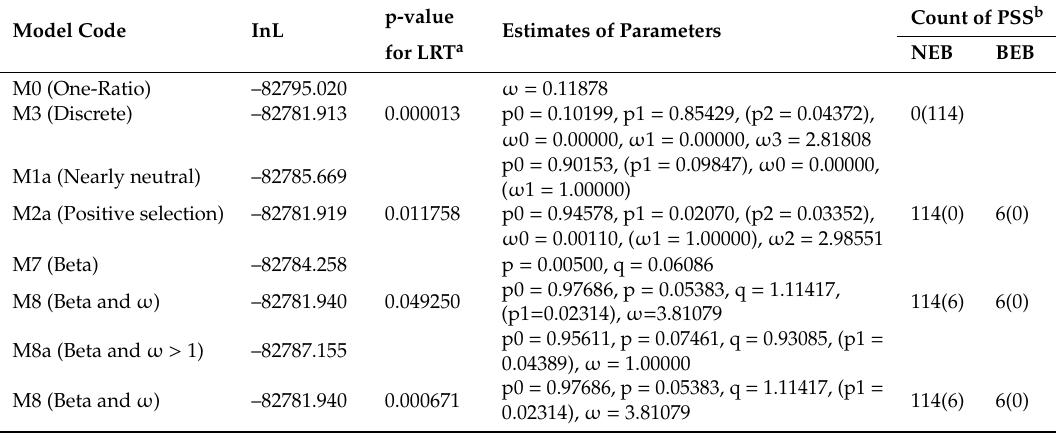
Table 4. Log-likelihood values (InL) and parameter estimates under models of variable ω ratios among sites of 19,941 codons in 25 Avena chloroplast